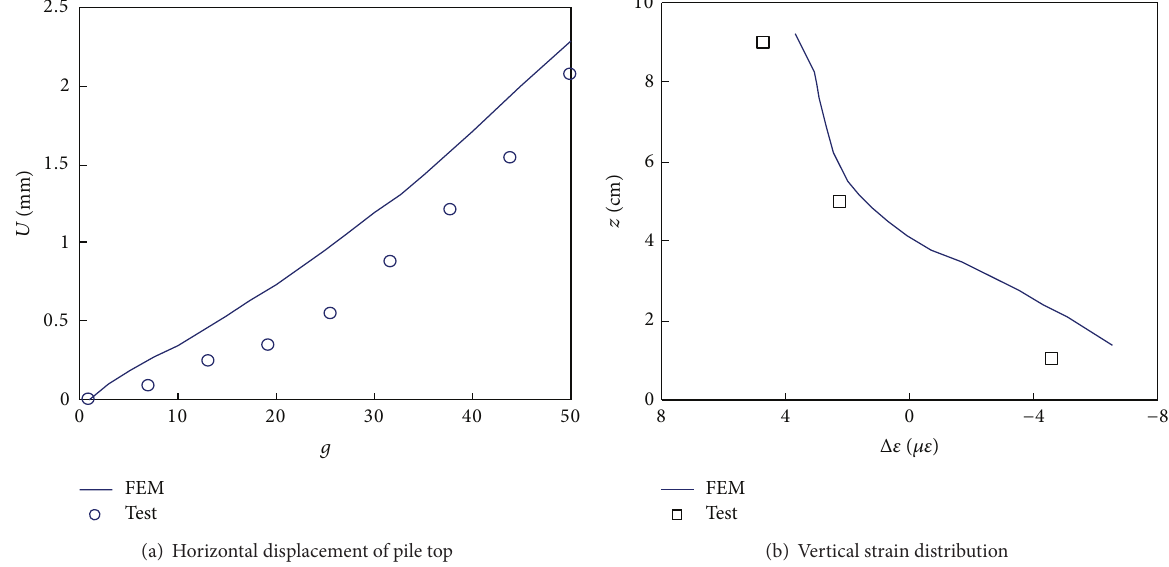
Figure 7: Response of the pile by numerical analysis and test results. u : horizontal displacement of pile top; Δ𝜀 : vertical strain difference between right and left sides of pile.